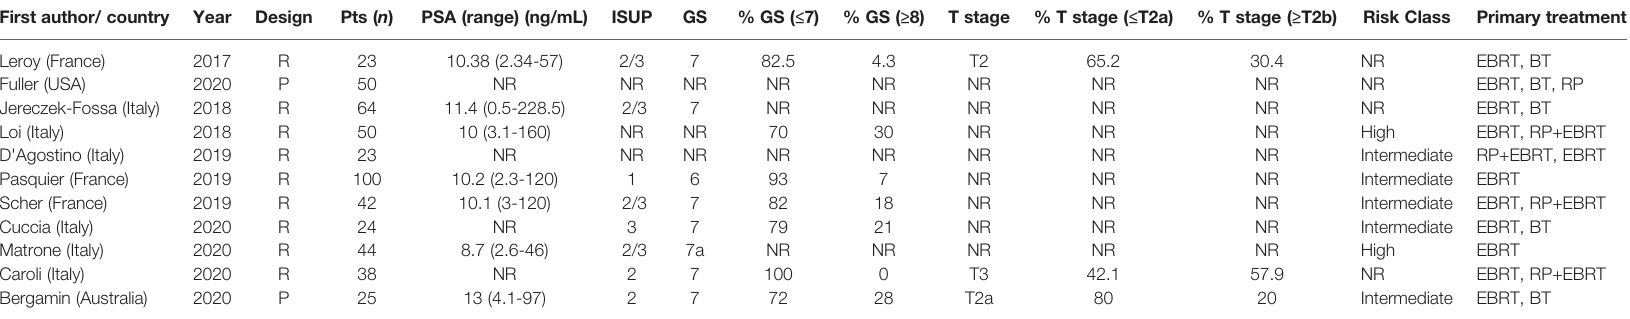
TABLE 4 | Primary disease and treatment characteristics for EBRT studies. First author/ country Year Design